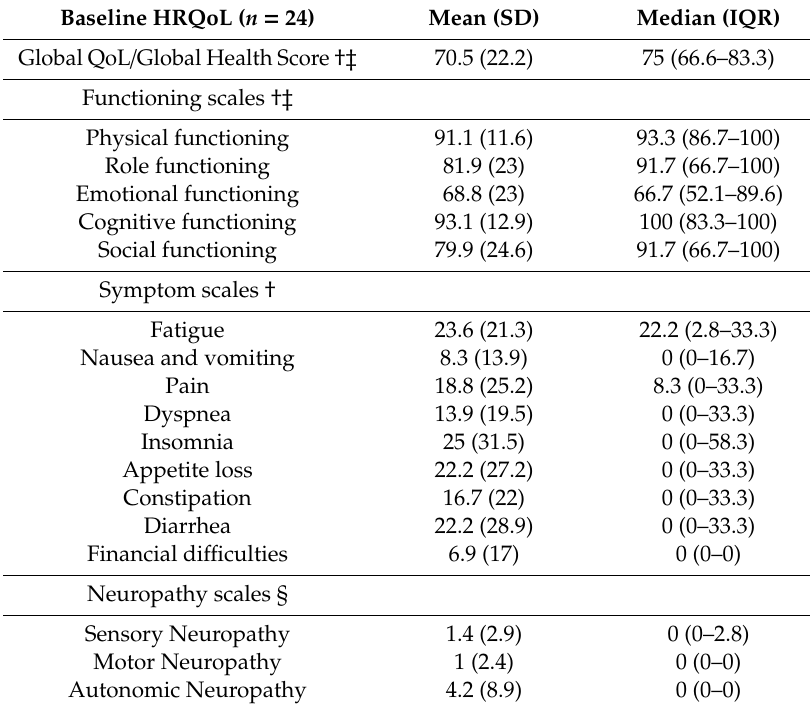
Table 4. Baseline health-related quality of life (HRQoL) and